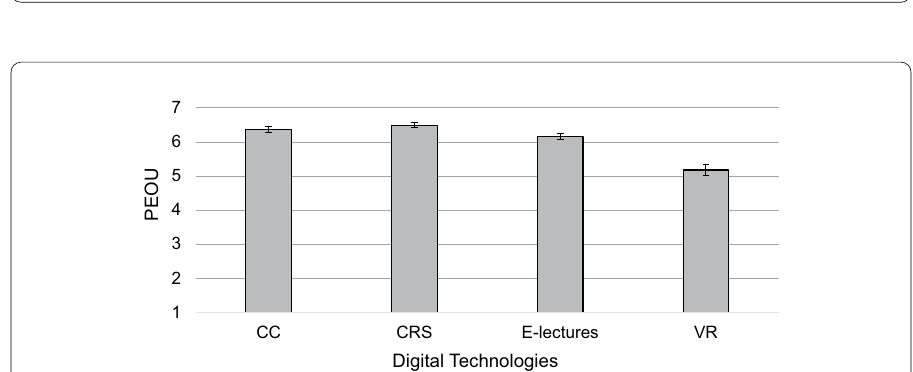
Fig. 6 Perceived ease of use for the CC, CRS, e-lectures, and VR after three months of usage. The error bars represent the standard errors of the